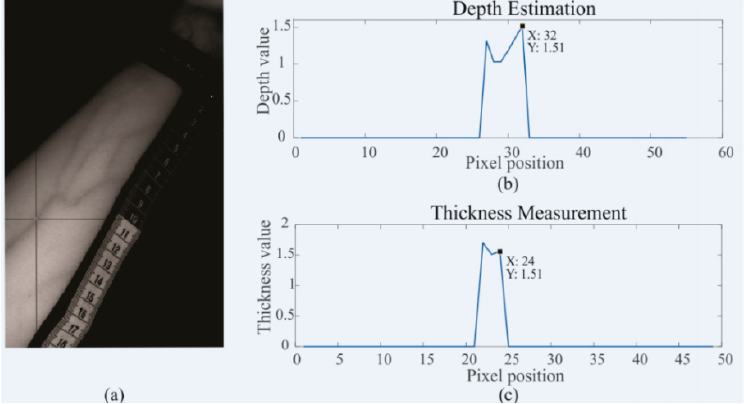
Figure 6. ( a ) Selecting a point from fused images to extract values of: ( b ) Depth and ( c ) thickness using the proposed imaging system [71].